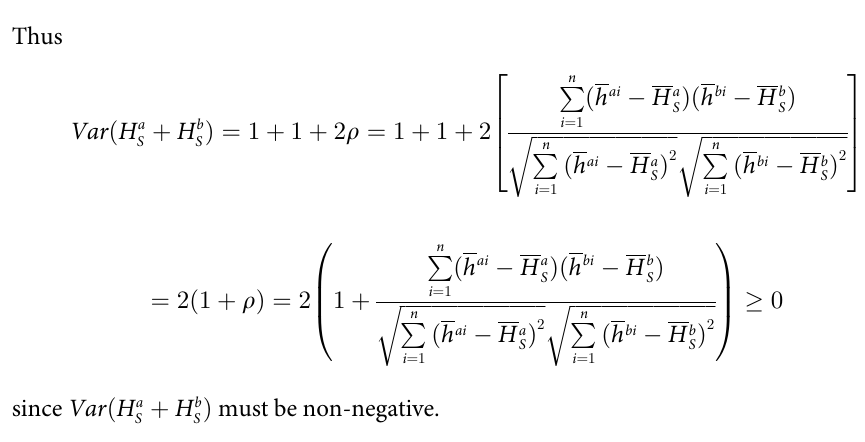
ffiffiffiffiffiffiffiffiffiffiffiffiffiffiffiffiffiffiffiffiffiffiffiffiffiffiffiffi P n